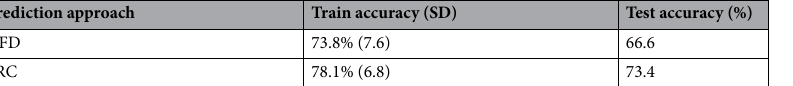
Table 1. Overall accuracy of the random forest models developed for classifying stickleback and whitefish using numerical feature descriptors (NFD) and the frequency response curves (FRC) estimated for training data through cross validation (CV accuracy) and for test data (Test accuracy). For CV accuracy, the mean accuracy and standard deviation was estimated through tenfold cross validation with three repeats.